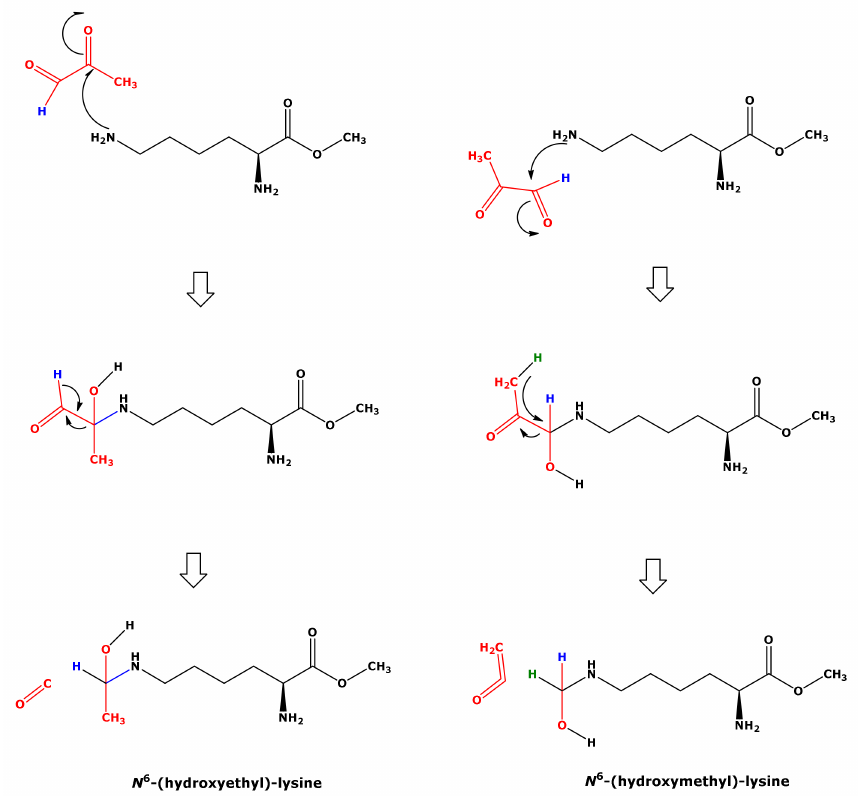
Figure 8. Proposed mechanism for the formation of hydroxymethyl-lysine (right panel) from the reaction of free lysine methyl ester with methylglyoxal (MGO) in 100 mM phosphate buffer (pH